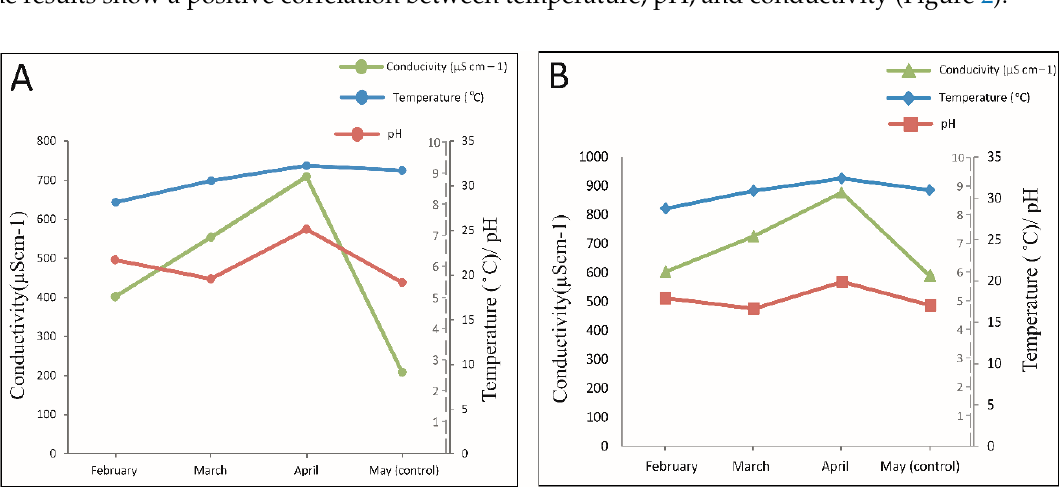
Figure 2. Relationship between temperature, pH and conductivity observed in two swimming pools (‘ A ’ and ‘ B ’) in the Tamale Metropolis. The broken y-axes indicate pH, while the continuous line indicates temperature.